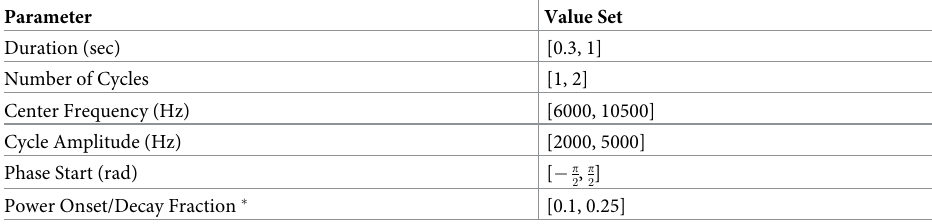
Table 2. Parameter values of created tonals.